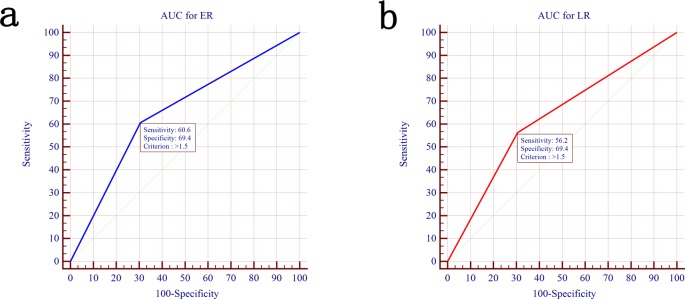
Receiver-operating characteristic (ROC) of the optimal cutoff values for preoperative serum CRP in predicting ER and LR.(a) Preoperative serum CRP as indicator of ER with the area under the curve (AUC) of 0.65 (95% CI, 0.58–0.72) and the optimal cutoff point was 1.5 mg/dl with a sensitivity of 60.6% and a specificity of 69.4%. (b) Preoperative serum CRP as indicator of LR with the AUC of 0.63 (95% CI, 0.54–0.71). The optimal cutoff point was 1.5 mg/dl with a sensitivity of 56.2% and a specificity of 69.4%.